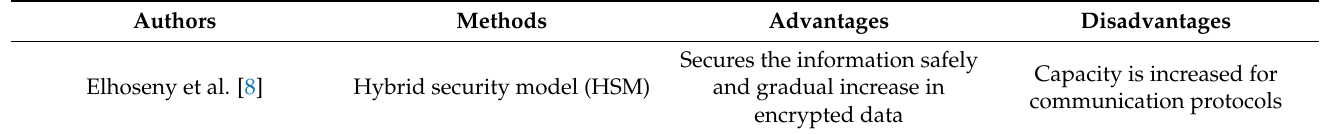
Table 1. Literature analysis based on healthcare